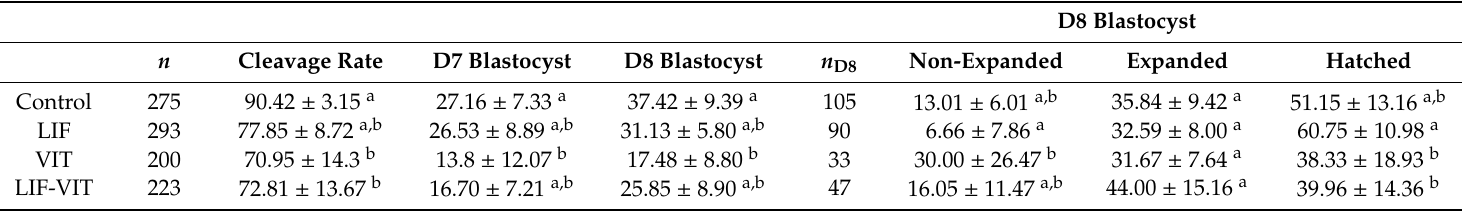
Table 1. Developmental competence of bovine oocytes in vitro matured in a medium supplemented with leukemia inhibitory factor (LIF) prior to vitrification / warming.